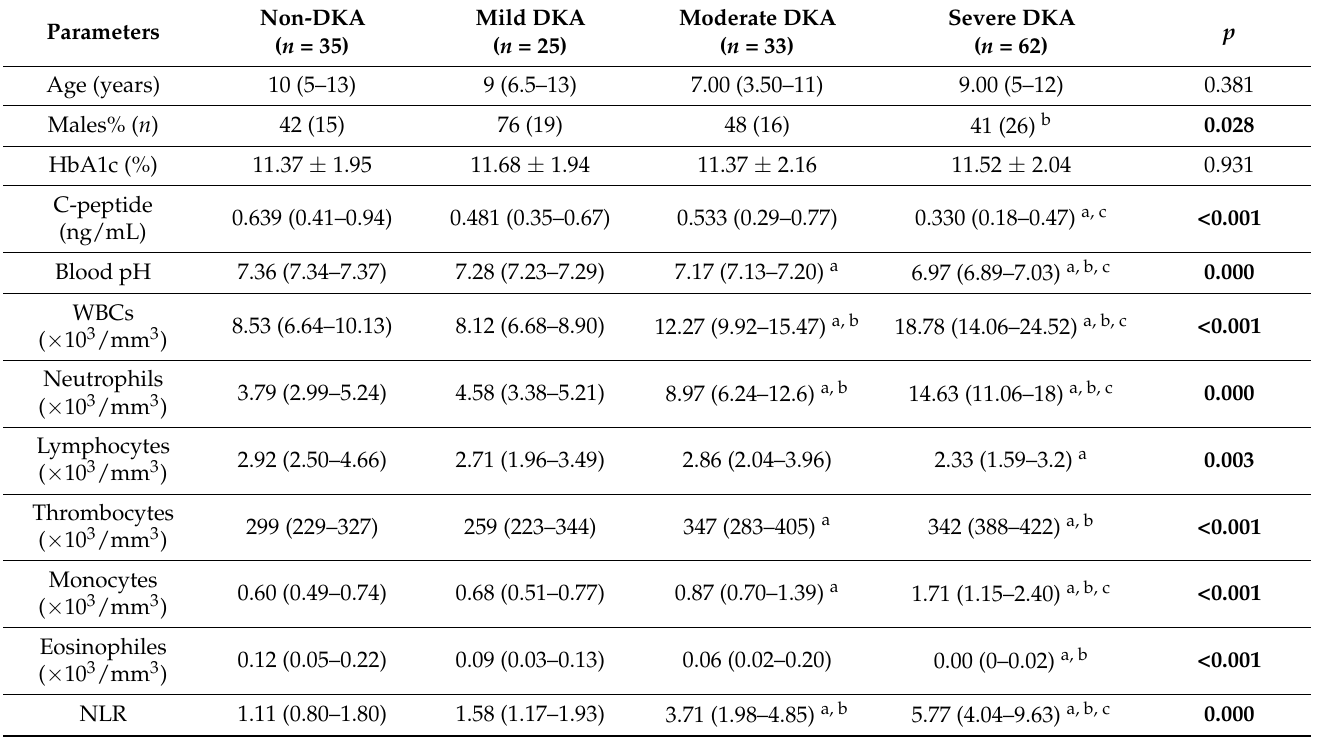
Table 1. Demographic data and laboratory findings of all